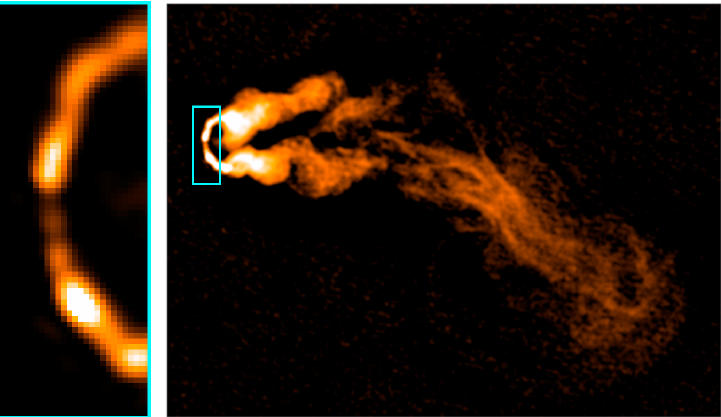
Figure 1. Is this not a WAT? Illustrative new images using the VLA data presented in Gendron-Marsolais et al. [3]: ( Left ) close-up view of the head of NGC 1265; ( Right ) larger scale view of the same